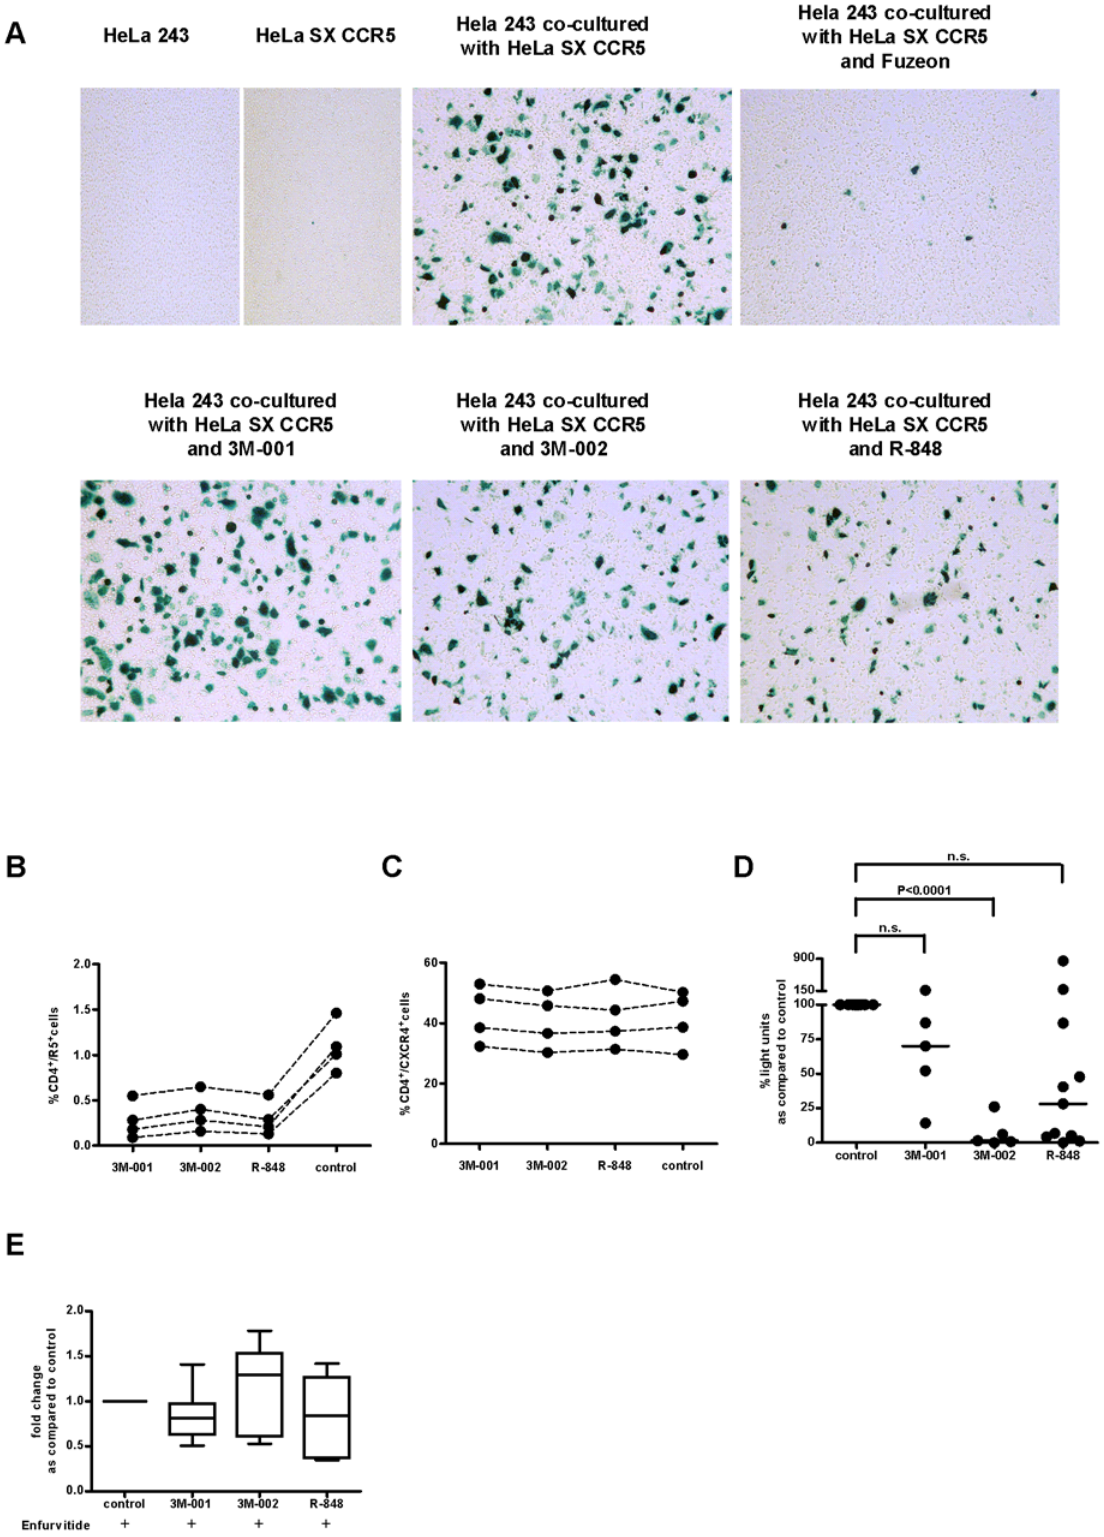
Figure 6. Triggering TLR8 and/or 7/8 blocks HIV replication after HIV entry but before integration. (A) Unspecific inhibitory effects of the compounds triggering TLR7 and/or 8 on HIV entry was examined with a cell-cell-based fusion assay, in which one cell line expresses the HIV-gp120 and an LTR-driven lacZ gene (HeLa SX CCR5) and the other cell line expresses the HIV receptor complex (CD4 and CCR5) and Tat (HeLa 243). Fusion of these cell lines will result in Tat driven LTR lacZ gene expression which we quantified histochemically by staining for b -galactosidase activity (n=2). (B and C) Percentage of C4 + T-cells expressing CCR5 and CXCR4 was quantified by flow-cytometry two days after triggering TLR7 and/or 8 of PBMC